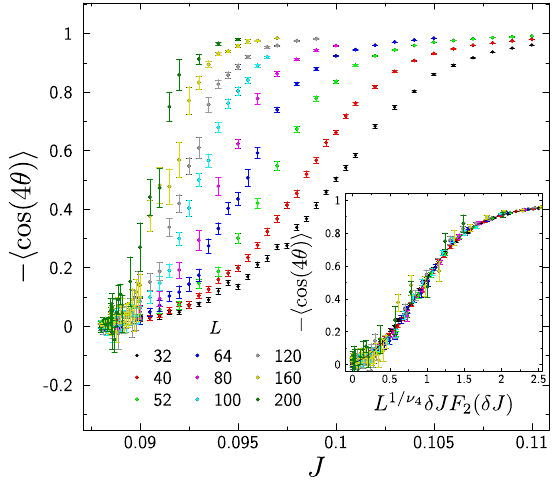
FIG. 12. Data for h cos ð 4 θ Þi versus J in several system sizes. Inset: h cos ð 4 θ Þi as a function of the scaling variable L 1 = ν 4 ð J − J F 2 ð J − J c Þ c Þ